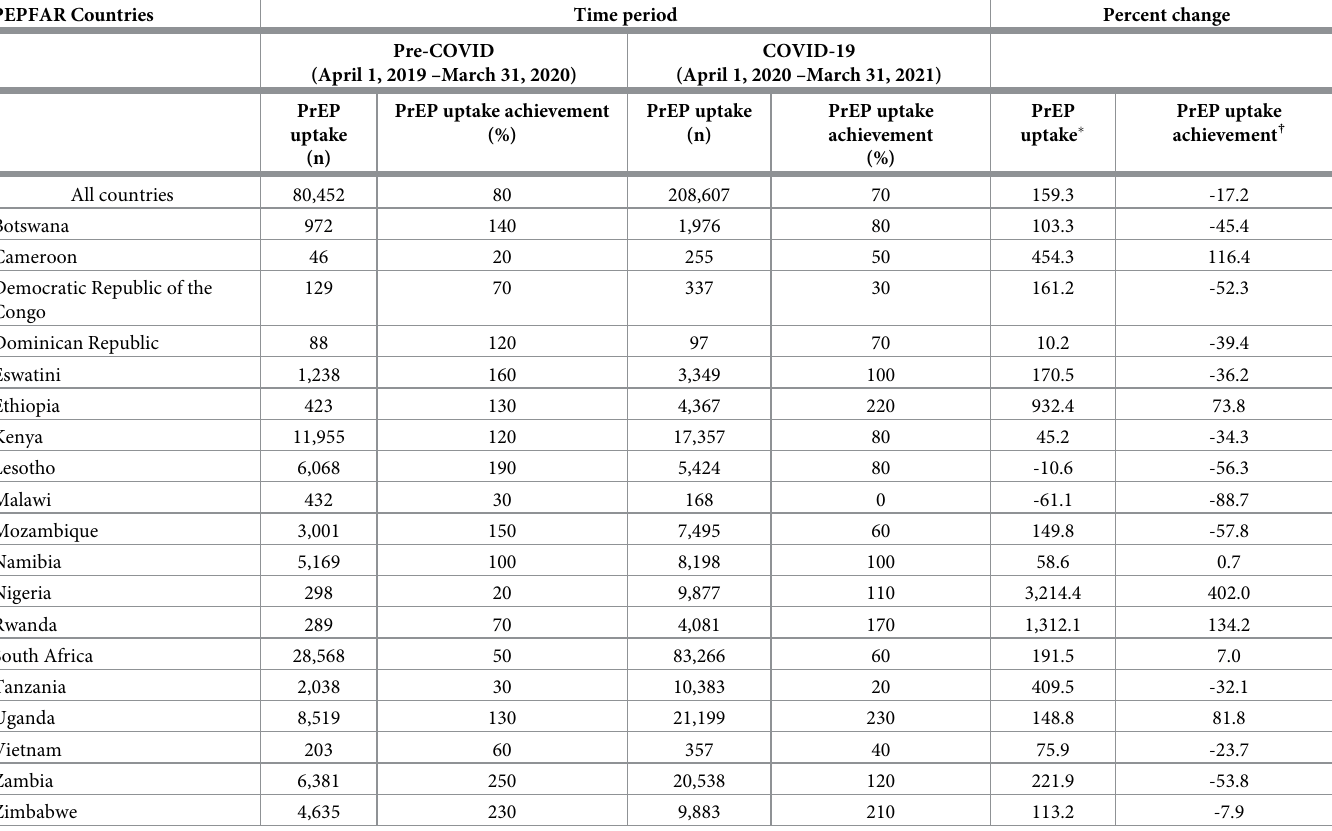
Table 2. New and current preexposure prophylaxis (PrEP) users in PEPFAR-supported countries, by pre-COVID-19 and COVID-19 time periods, among adoles- cent girls and young women aged 15–24 years. PEPFAR